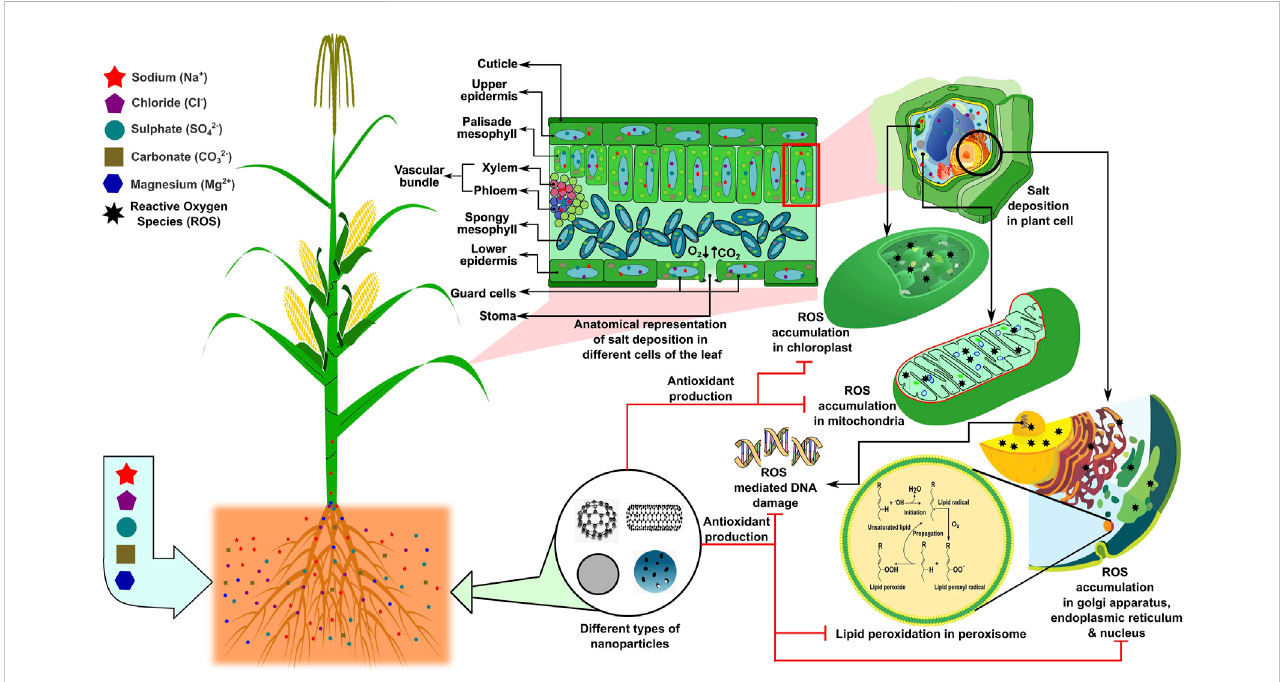
FIGURE 3 Higher salt concentration in plant cells results in a salt deposition in the leaf, leading to reactive oxygen species (ROS) accumulation in the chloroplasts, mitochondria,andnucleus.ROSaccumulationinsub-cellularorganellesmayfurtherleadtoDNAdamageandlipidperoxidation,whichcanbeneutralizedby applying nanotechnology, speci fi cally nano-delivery systems via the induction of antioxidant production and/or the direct inhibition of ROS production. The concept of the fi gure was inspired by Avestan et al. (2019) and Hussein and Abou-Baker (2018). The fi gure template was inspired by Berru (2007), Forluvoft (2008), LadyofHats (2013), LadyofHats (2006), McKenna (2006), Qef (2009), and Rifqi